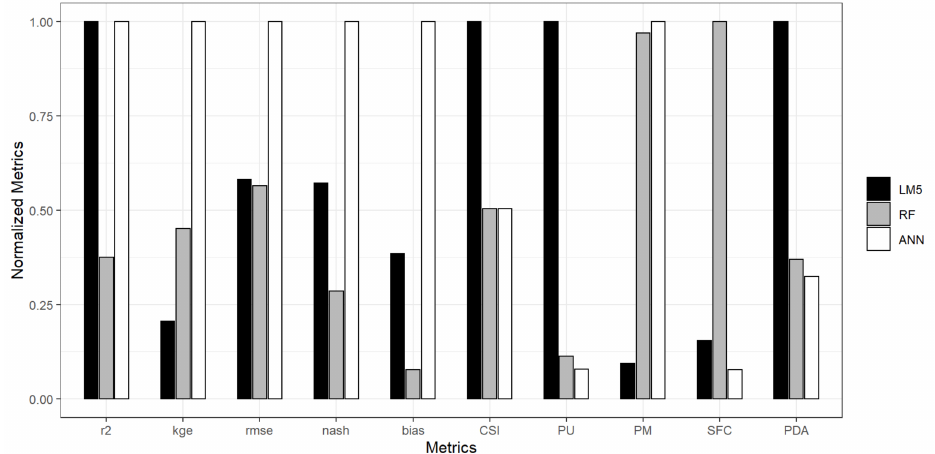
Figure 13. Normalized metrics for LM5, ANN, and RF models. Normalized indexes range is [0–1], where 0 is the best